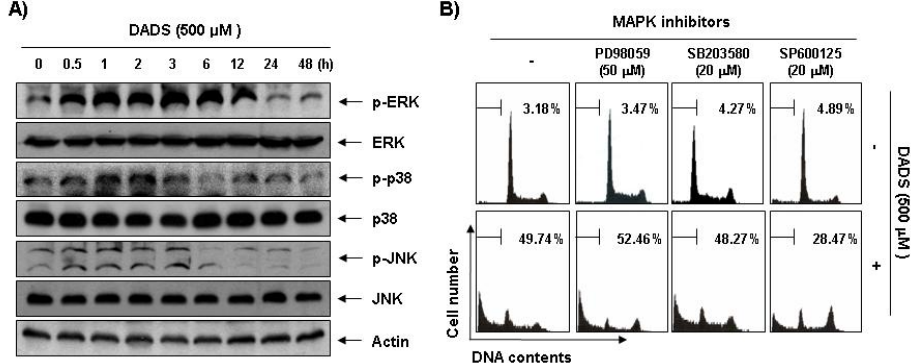
Figure 6. Effects of the activation of MAPKs on DADS-induced apoptosis in DU145 cells. ( A ) The cells were treated with DADS (500 µM) for the indicated times. They were then lysed, and equal amounts of cell lysates were resolved by SDS-polyacrylamide gels, transferred to nitrocellulose and probed with the indicated antibodies; ( B ) The cells were pretreated with the indicated MAPK inhibitors (SB203580, 20 µM; SP600125, 20 µM; and PD98059, 50 µM) for 1 h and then treated with DADS (500 µM) for 48 h. The percentage of sub-G1 population was evaluated by a flow cytometer. The data are the mean ± SD of two different